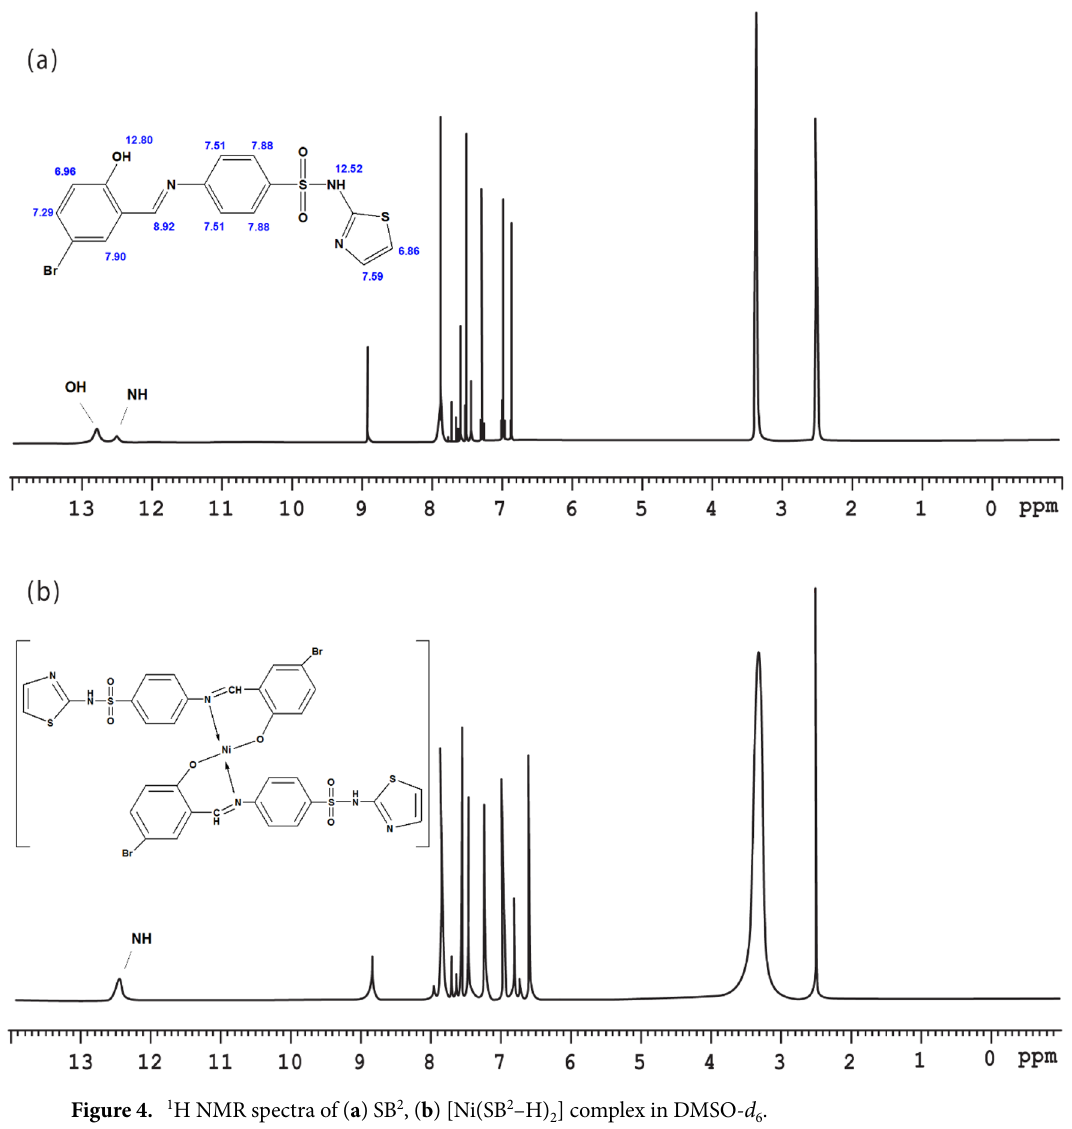
Figure 4. 1 H NMR spectra of ( a ) SB 2 , ( b ) [Ni(SB 2 –H) 2 ] complex in DMSO- d 6